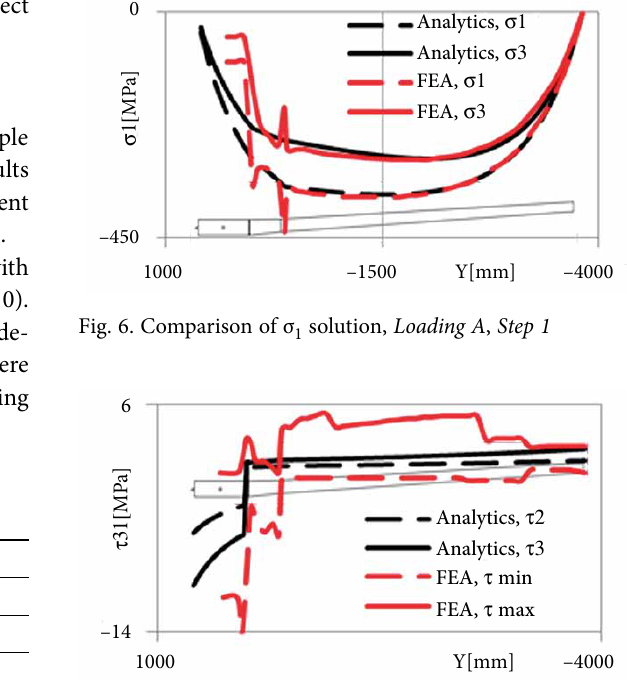
Fig. 7. Comparison of τ 31 solution, Loading C , Step